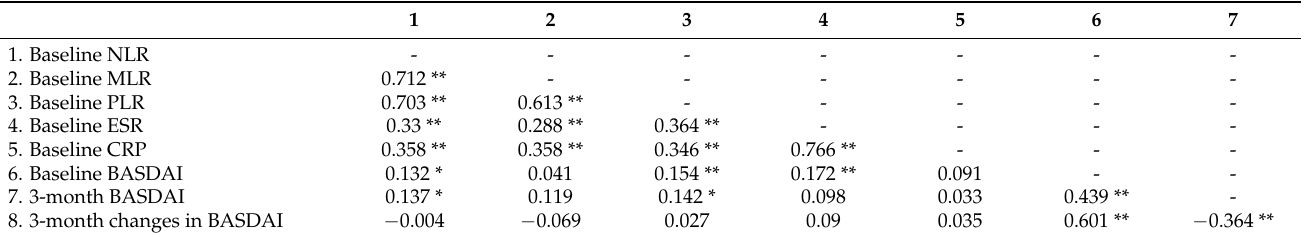
Table 2. Correlations between clinical and laboratory markers in patients with ankylosing